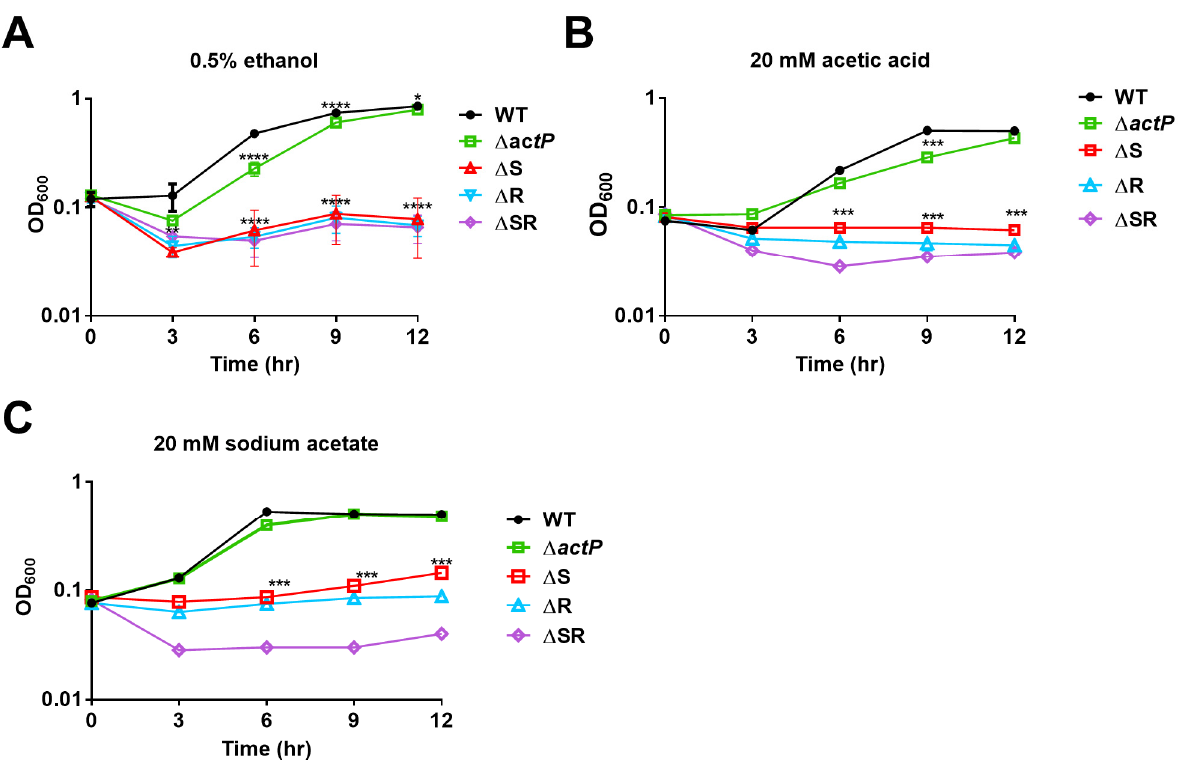
Figure 7. Growth curves of strains in ( A ) 0.5% ethanol, ( B ) 20 mM acetic acid, and ( C ) 20 mM sodium acetate. Black, green, red, blue, and purple lines respectively indicate wild-type and the actP , emaS , emaR , and emaSR mutants, respectively. Representative results from three independent experiments are shown. * p < 0.05; *** p < 0.001; **** p < 0.0001.